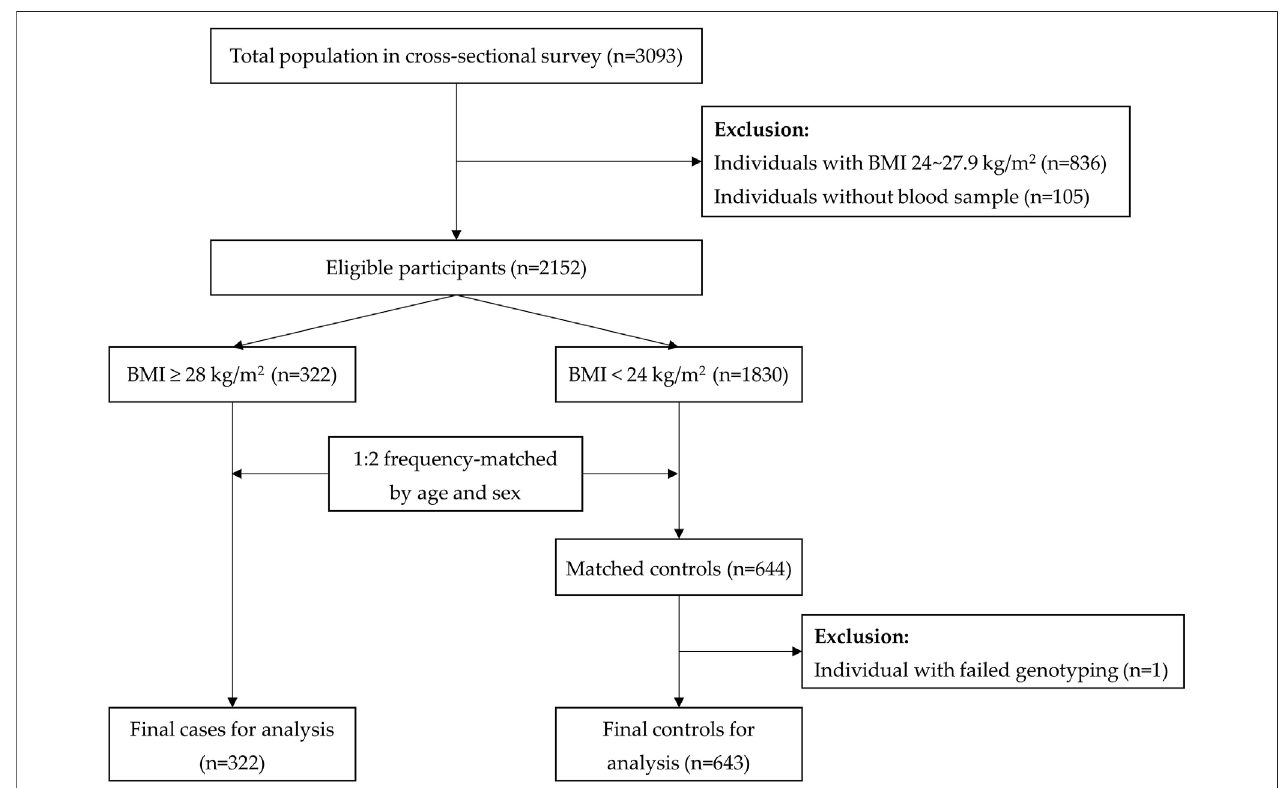
FIGURE 1 | Flow chart of selection of participants in the case – control